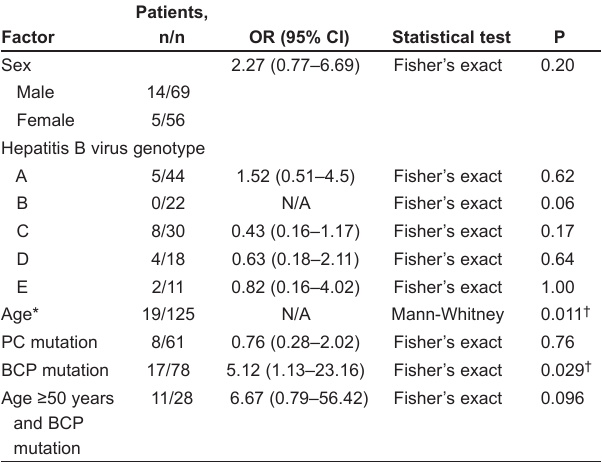
Factors associated with an aspartate aminotransferase-to-